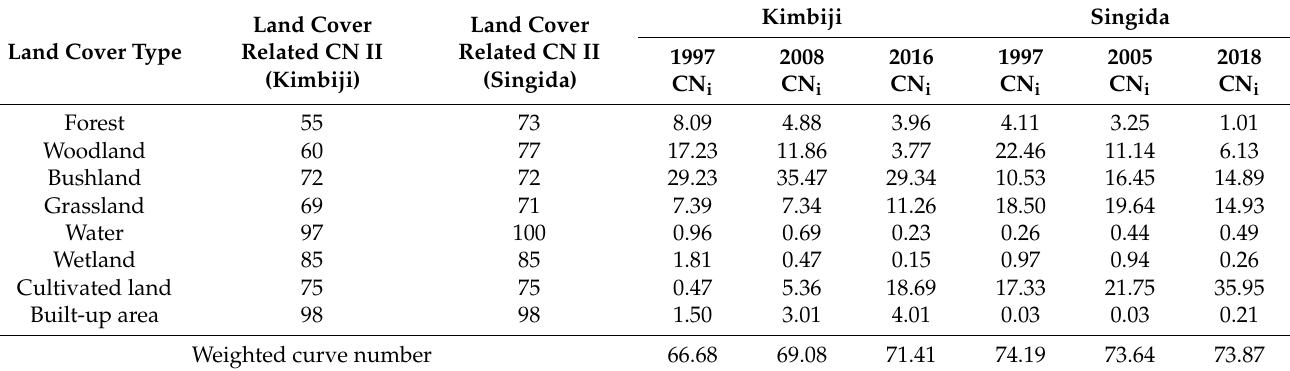
Table 9. Land cover related average and weighted curve number for the Kimbiji and Singida Aquifers.